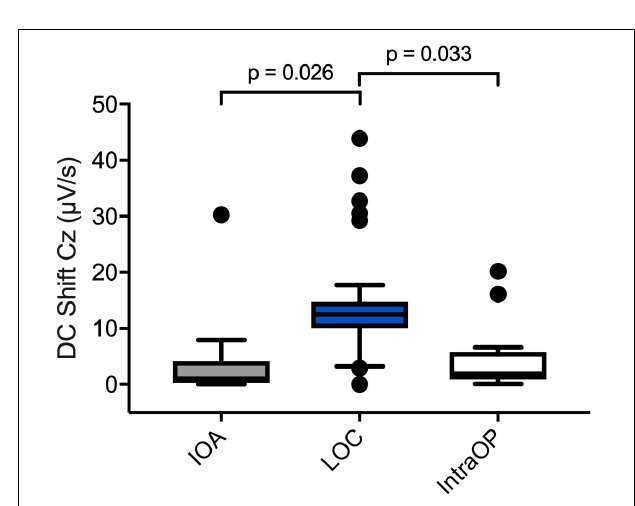
FIGURE 6 | Perioperative DC shifts at different time points. Boxplots depicting DC shifts averaged over all patients during IOA ( n = 13), LOC ( n = 12), and intraOP ( n = 13). The shift at the LOC segment was significantly larger than during the IOA or intraOP segment. A one-way repeated measures analysis of variance test was used to compare the DC